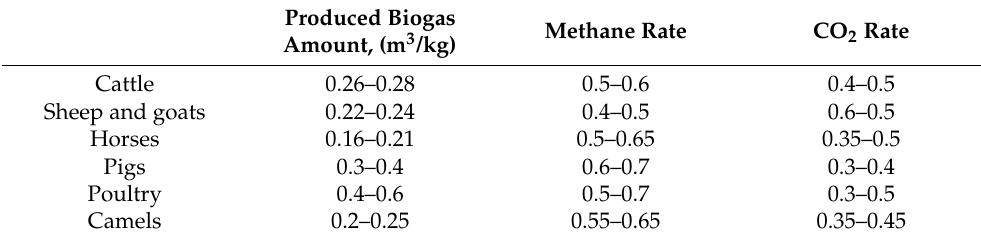
Table 3. Biogas and methane produced from different manures